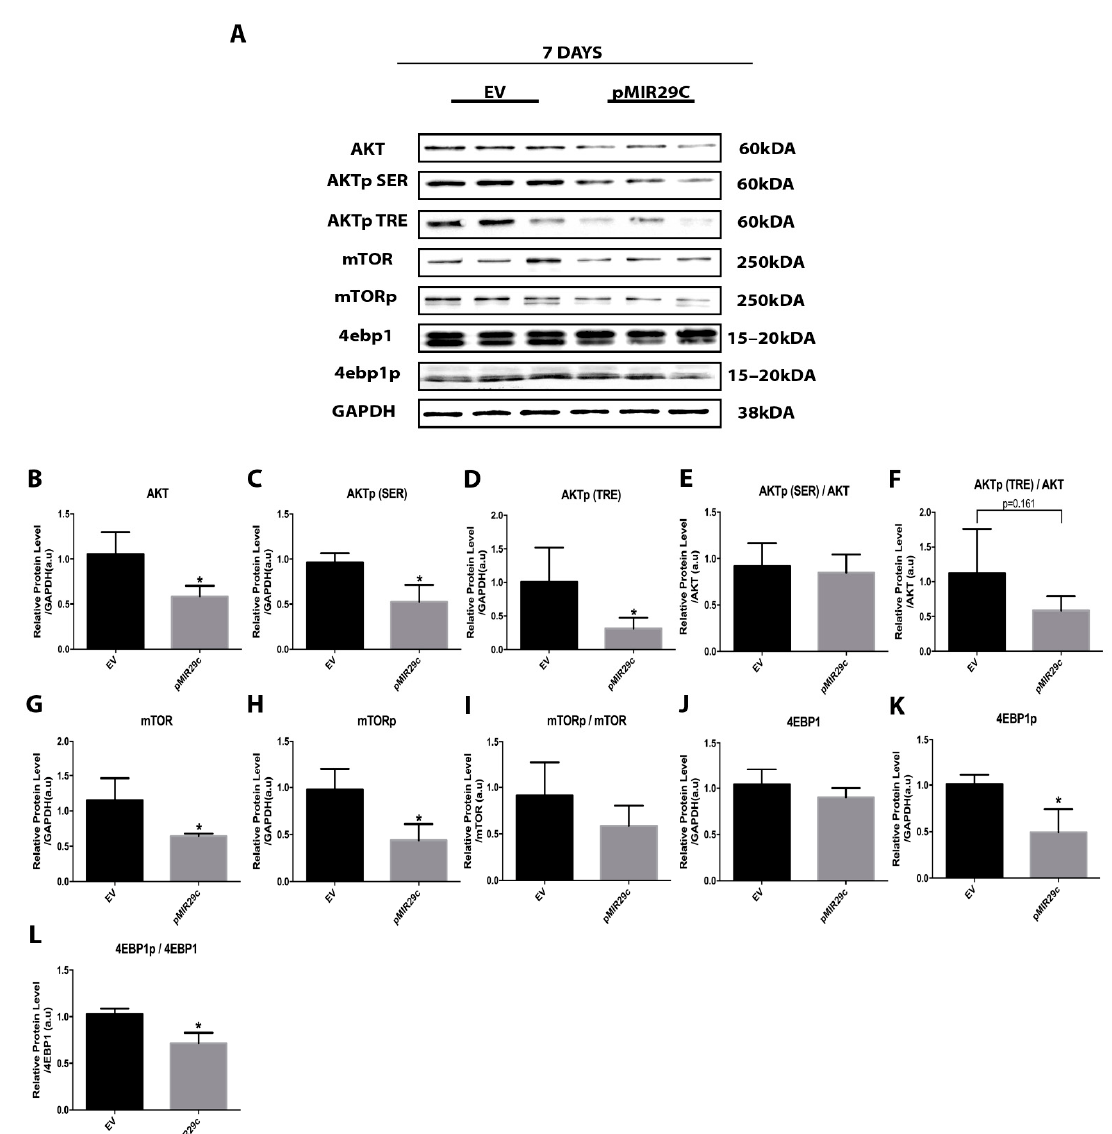
Figure 3. Phosphorylation and total protein involved in AKT/mTOR signaling after 7 days of miR-29c overexpression. ( A ) Representative bands after 7 days of miR-29c overexpression. Densitometry analysis of AKT ( B – F ), mTOR ( G – I ), and 4EBP1 ( J – L ) bands ( n = 5 per group). Data are presented as mean ± SD. Statistical analysis included an unpaired t -test and a Mann–Whitney test. * p < 0.05 vs. EV